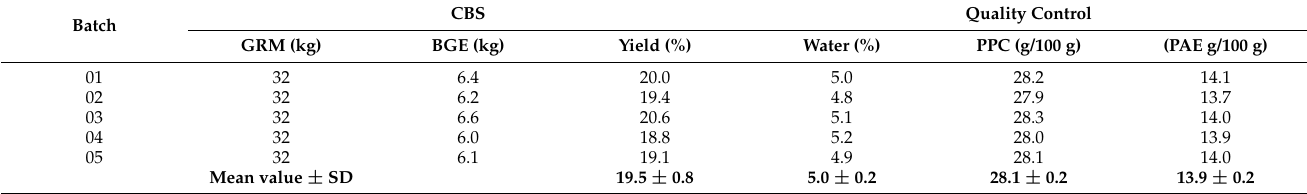
Table 8. Yield and quality determinations of cocoa bean shell-bioactive green